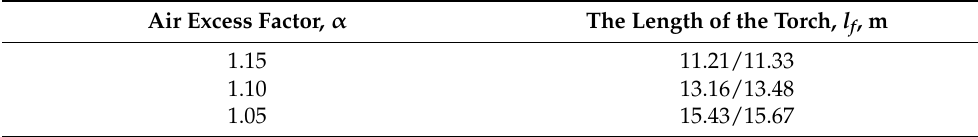
Table 7. Results of using new approximation methods on a real object of